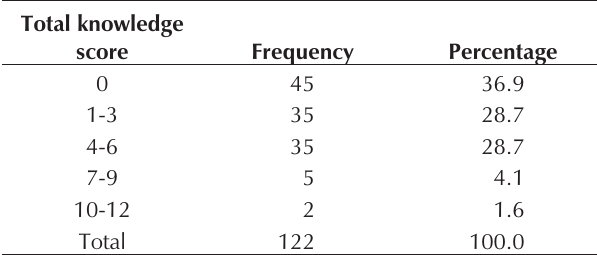
Total knowledge scores of the Kanghwa, Korea survey popula-